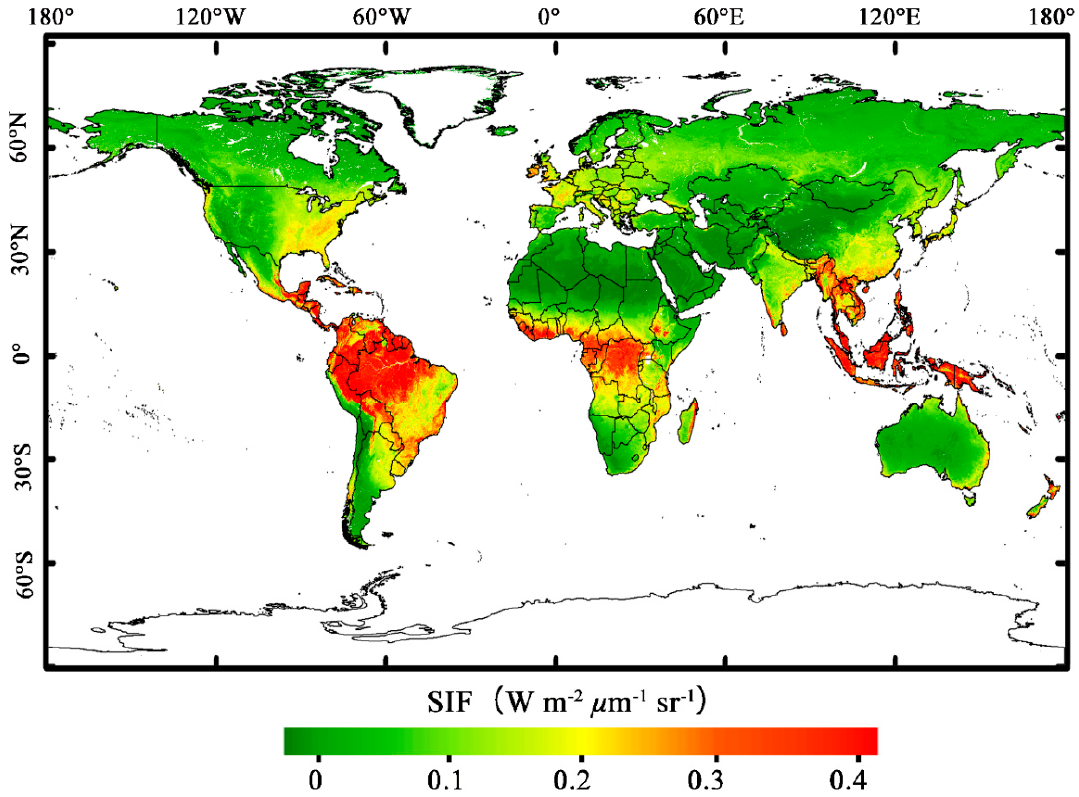
Figure 9. Magnitude and spatial patterns of the annual mean SIF of our GOSIF product (0.05 ° , 8-day) over the period from 2001 to 2017. The units are W m − 2 μ m − 1 sr − 1 .